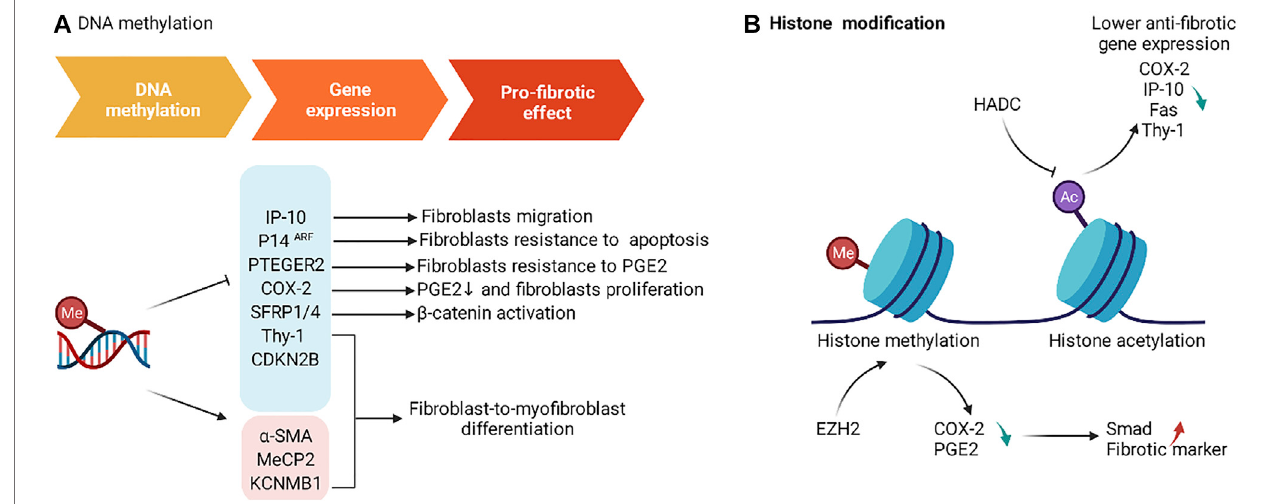
FIGURE5| TherolesofDNAmethylationandhistonemodi fi cationinIPF. (A) DNAmethylationaffectstheexpressionofgeneassociatedwith fi brosisandproduces a pro- fi brotic effect. (B) EZH2 and HADC induce changes in gene expression associated with fi brosis by affecting histone modi fi cations.